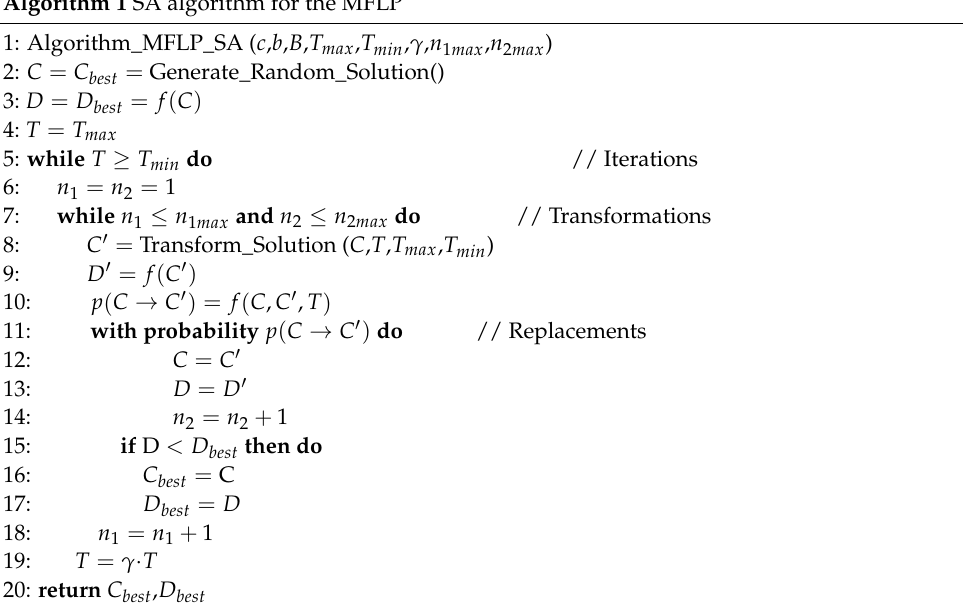
Algorithm 1 SA algorithm for the